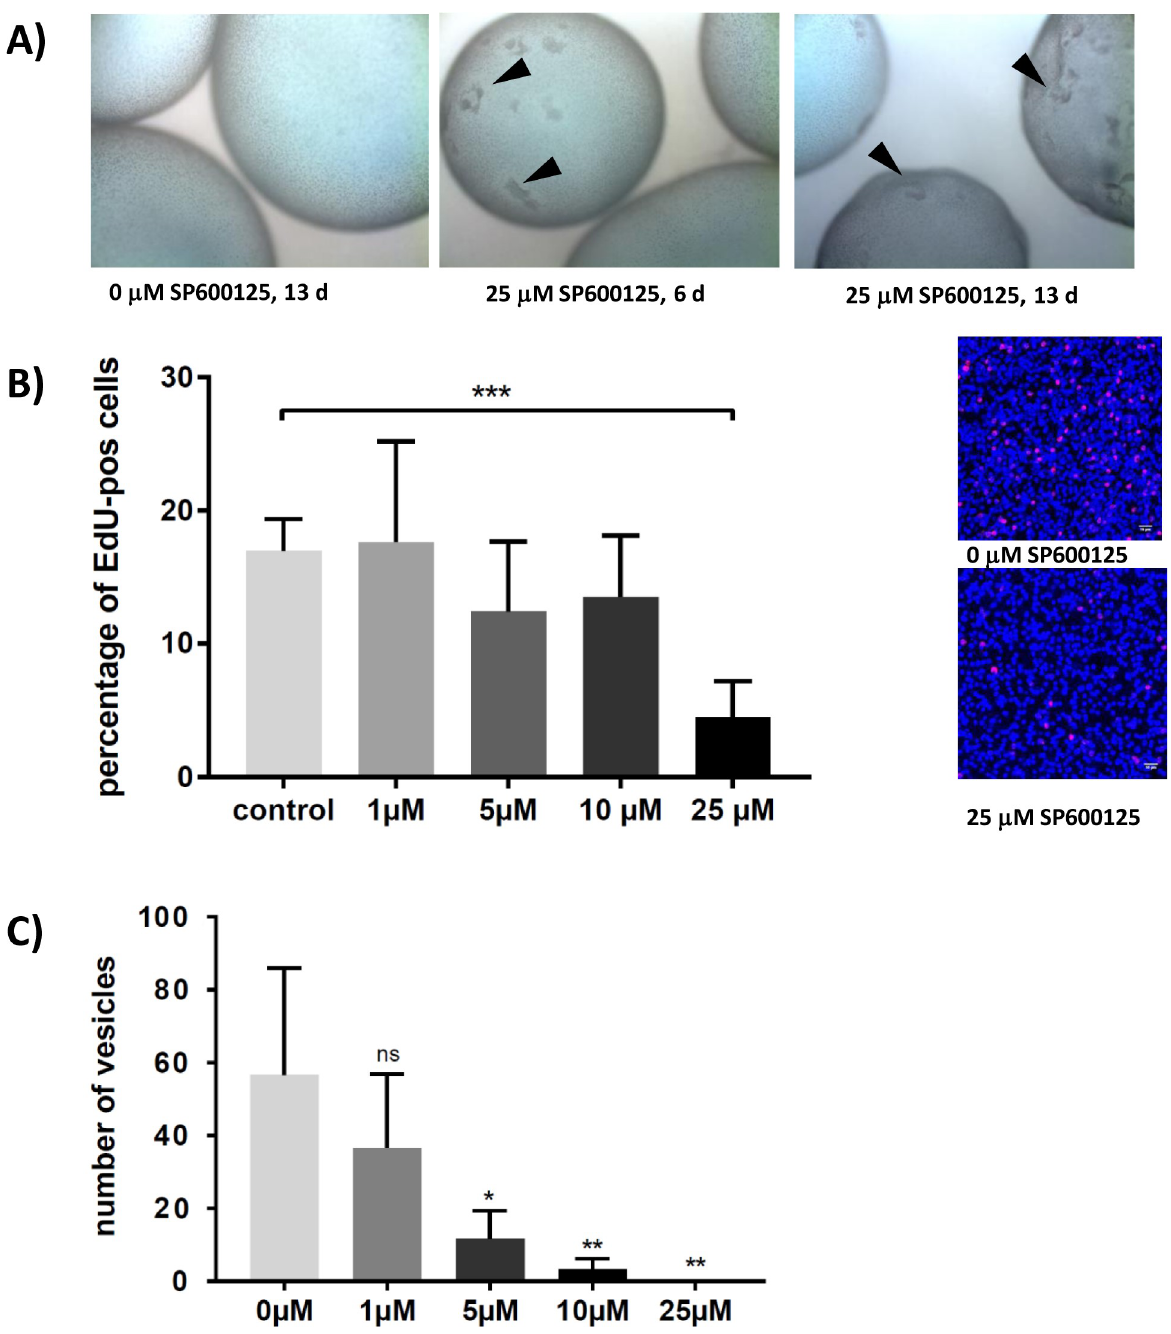
Fig 7. Effect of SP600125 on metacestode vesicles and parasite stem cells. A) Effect on metacestode vesicles. Upper panel: Microscopic images of in vitro cultivated metacestode vesicles after incubation with 25 μ M SP600125. left: control without inhibitor; middle: 25 μ M SP600125 for 6 days; right: 25 μ M SP600125 for 13 days. Lesions in the germinal layer are marked by black triangles. B) Effect of SP600125 on percentage of EdU + cells in germinal layer. Vesicles had been incubated for 13 days in the presence of SP600125 at concentrations as indicated. Left: dose-dependent effect of SP600125 on number of EdU+ cells in the germinal layer. Statistical analysis of three biological replicates ( ��� , p < 0,0001). Right: Examples of EdU+ cells in germinal layer of vesicles incubated with 0 μ M (control) and 25 μ M SP600125 as indicated. C) Effect of SP600125 on vesicle formation from primary cells. Primary cell cultures had been incubated in the presence of SP600125 at indicated concentrations for 19 days and fully mature vesicles were counted. Statistical analysis of three biological replicates. ns, non significant; � , p = 0,02; �� , p < 0,008.